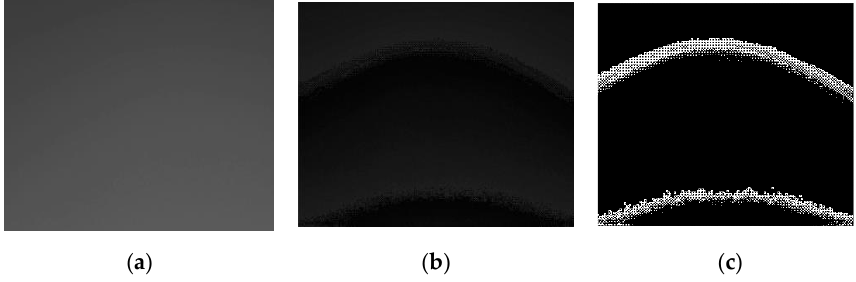
Figure 3. An example of the edge detection procedure on a fingertip image obtained from a smartphone video camera: ( a ) greyscale image in YUV raw image; ( b ) preprocessed image; and ( c ) the edge detected image.